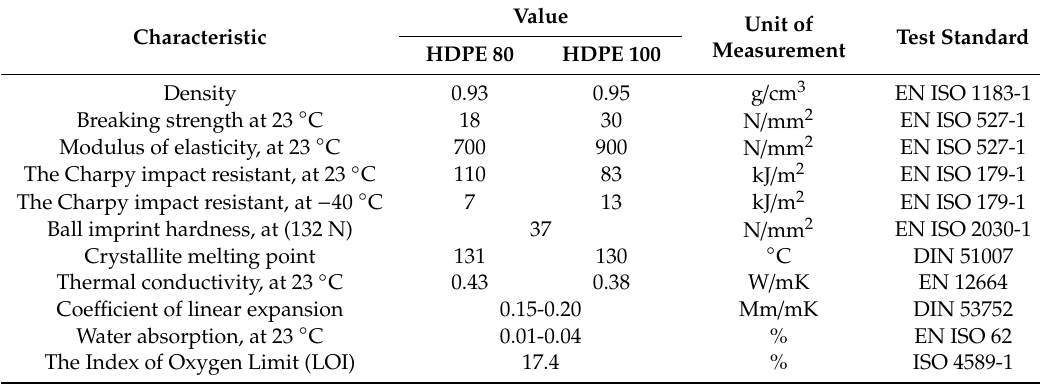
Table 5. The main physical-mechanical properties of HDPE.